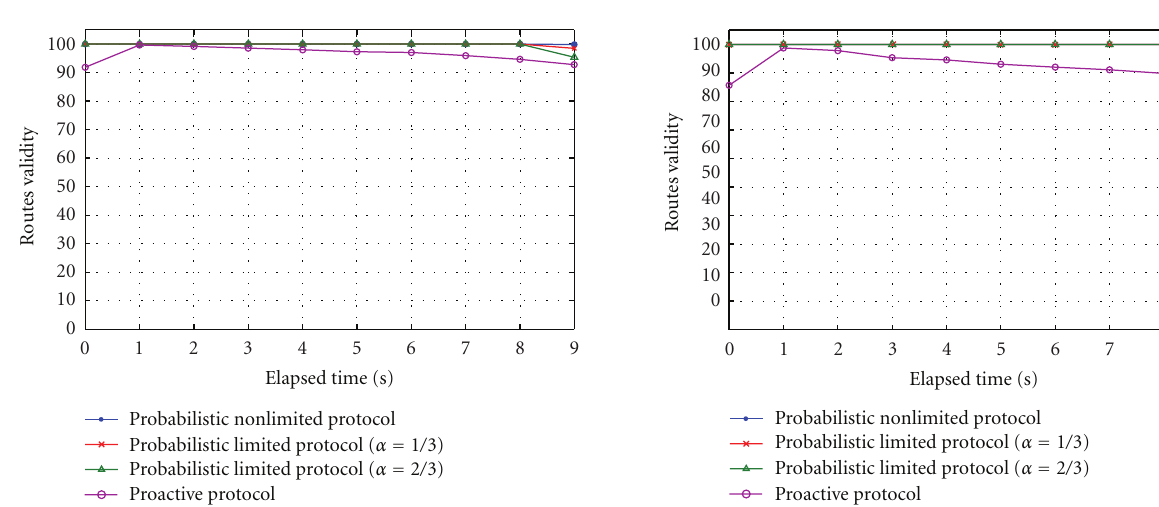
Figure 6: Percentage of valid probabilistic routes as a function of the elapsed time, V = 2 m/sec.